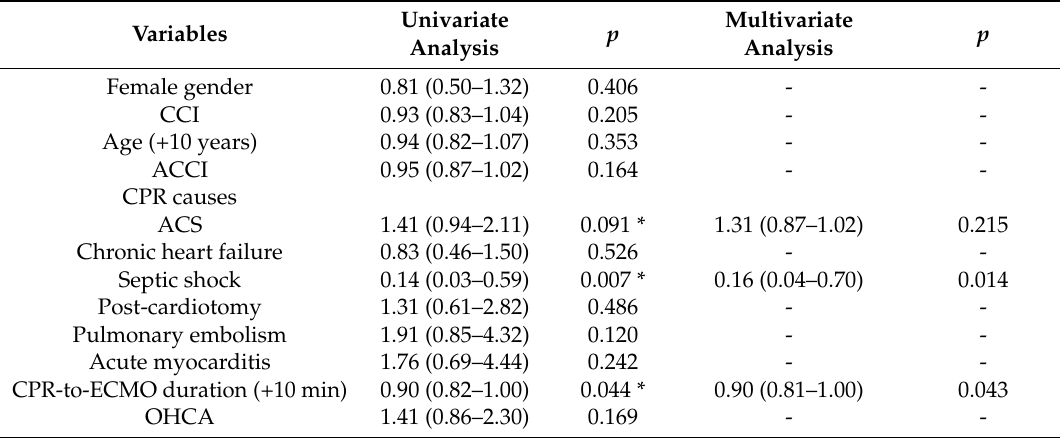
Table 3. Logistic regression analysis for hospital